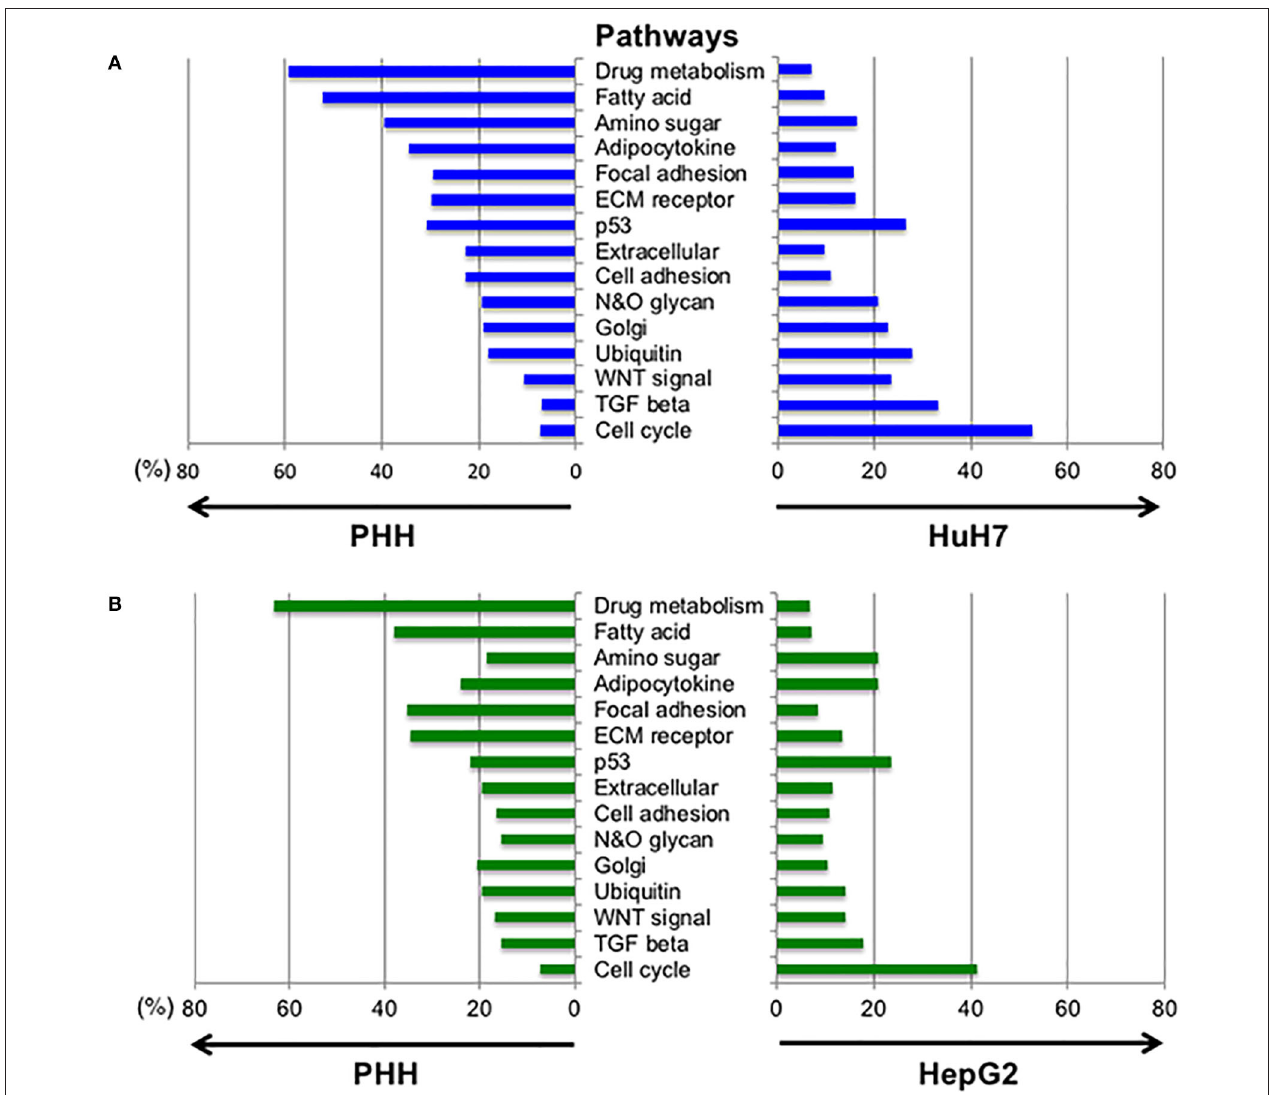
FIGURE 5 | Altered expression profiles between normal and hepatic cancer cell lines in the selected pathways. To examine the changes in gene expression between PHH and HCC cells, the expression profiles of genes in different pathways were compared. Expression levels of the genes listed in 15 pathways designated by the KEGG database were extracted and the genes with fold-changes > 2 and an FDR-corrected p -value lower than 0.05 were selected. The highly expressed genes in PHH cells compared to HuH7 cells (A) and HepG2 cells (B) are denoted at the left side of each panel while the right side shows increased expression in HCC cell